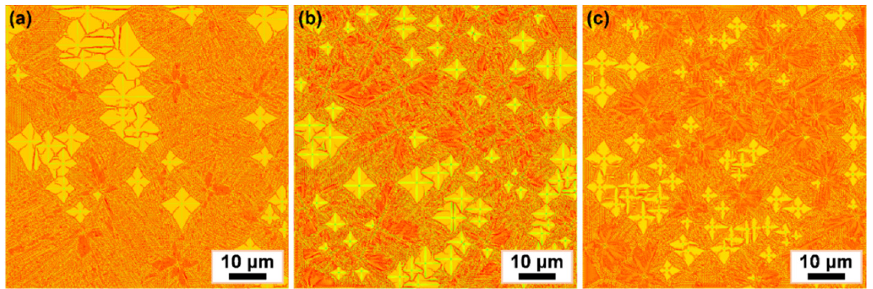
Figure 8. Simulation results of Al ‐ Si eutectic morphologies under different eutectic undercooling conditions: ( a ) Δ T e = 5 K; ( b ) Δ T e = 15 K; ( c ) Δ T e = 20 K. conditions: ( a ) ∆ T e = 5 K; ( b ) ∆ T e = 15 K; ( c ) ∆ T e = 20